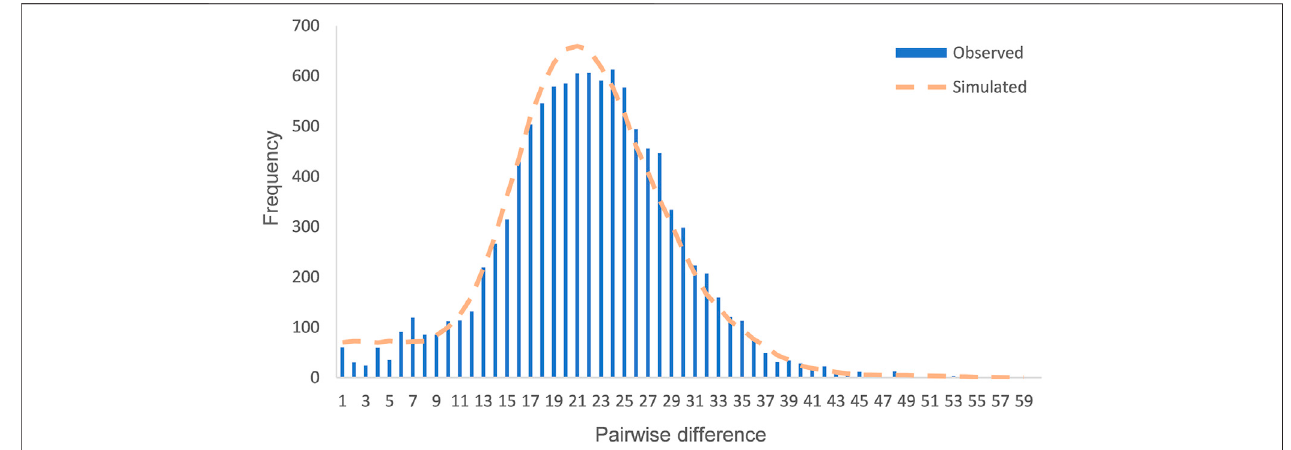
FIGURE 2 | Mismatch distribution of the Daur ethnic group. The orange dotted line represents the simulated model, and the blue bar graph represents the observed model of the Daur ethnic group.